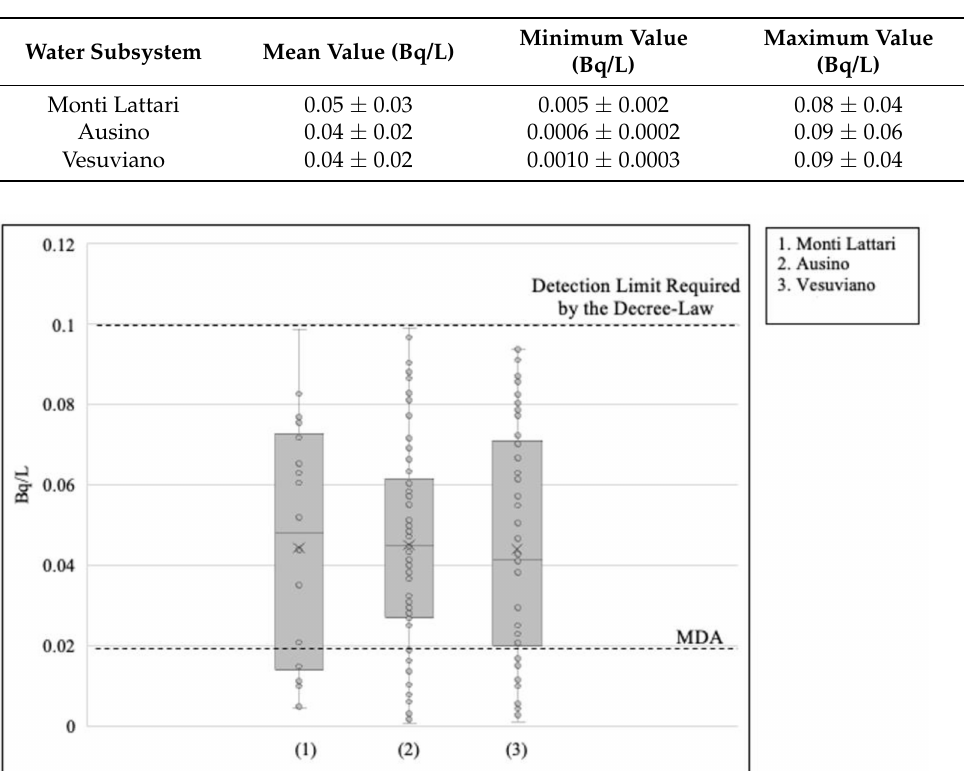
Table 5. Mean values of gross alpha activity concentration for each water subsystem analyzed.